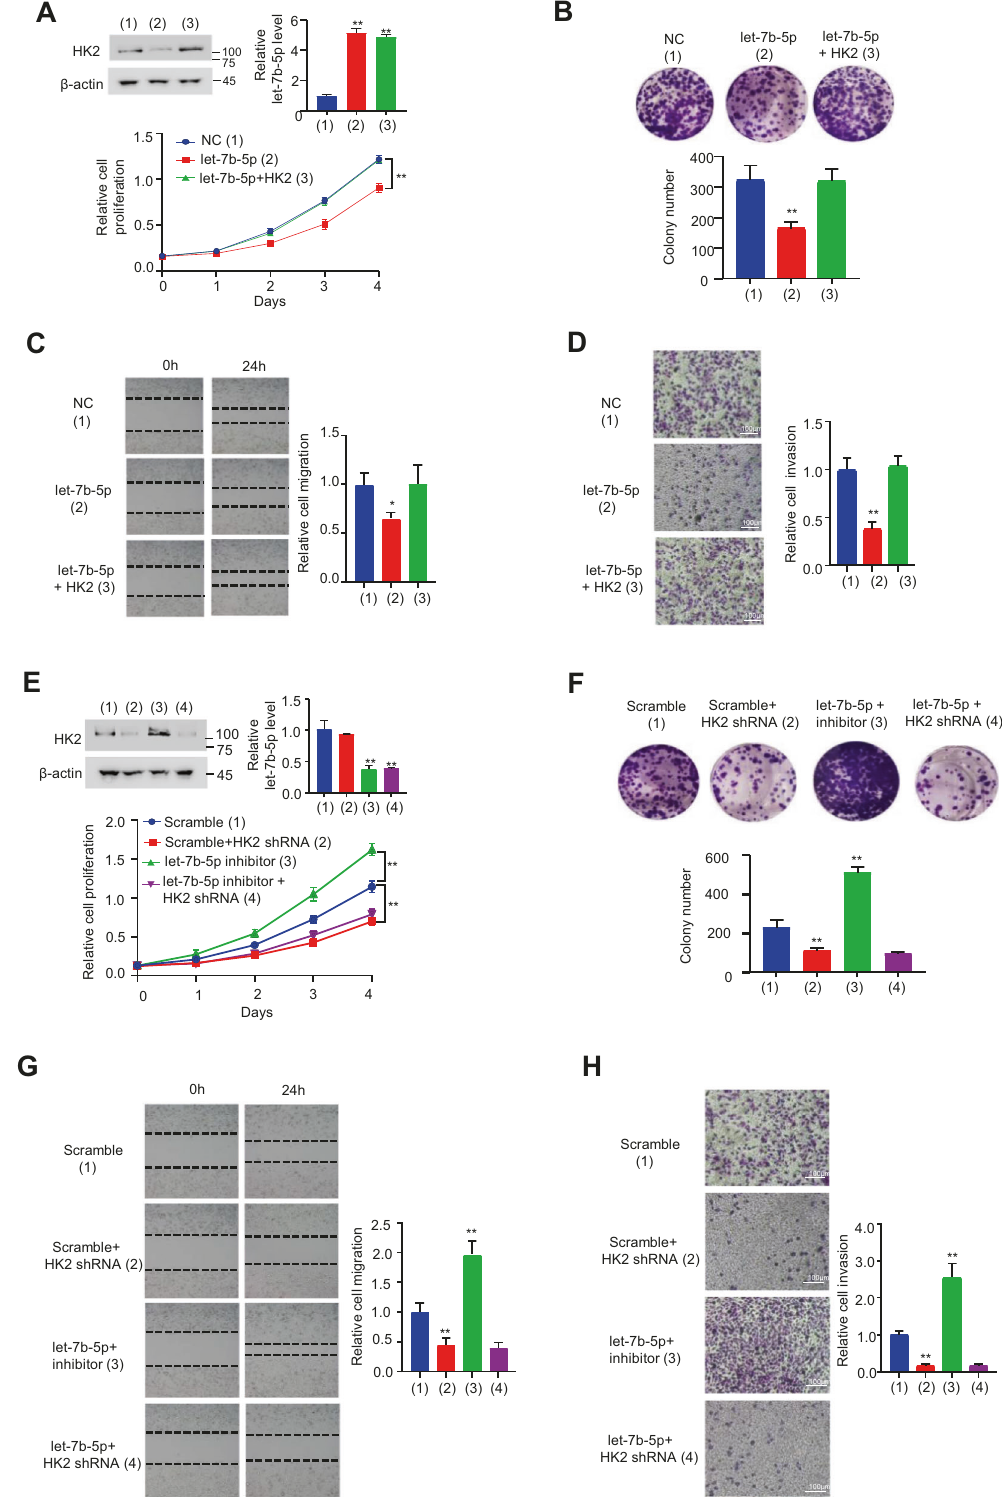
Fig. 3 Let-7b-5p dampens BC cell growth, migration, and invasion via repression of HK2 expression. A Growth curve was analyzed by CCK-8 Kit after MDA-MB-231 cells were transfected with NC, let-7b-5p mimic, or let-7b-5p mimic plus HK2 plasmid ( n = 3, mean ±SD). Western blot and RT- qPCR showed HK2 and let-7b-5p expression, respectively. B Colony formation analysis of MDA-MB-231 cells after the transfection as in ( A ). Histograms display the colony number ( n = 3, mean±SD). C , D Scratch test ( C ) and transwell assay ( D ) of MDA-MB-231 cells after the transfection as in ( A ). Histograms display relative cell migration or invasion ( n = 3, mean±SD). E , F Control or HK2 shRNA MDA-MB-231 cells with the transfection of let-7b- 5p inhibitor or scramble were analyzed as in ( A ) and ( B ) ( n = 3, mean±SD). G , H Scratch test ( G ) and transwell assay ( H ) of control or HK2 shRNA MDA-MB-231 cells with the transfection as in ( E , F ) ( n = 3, mean±SD). Scale bar, 100 μ m. * p <0.05, ** p <0.01 versus corresponding